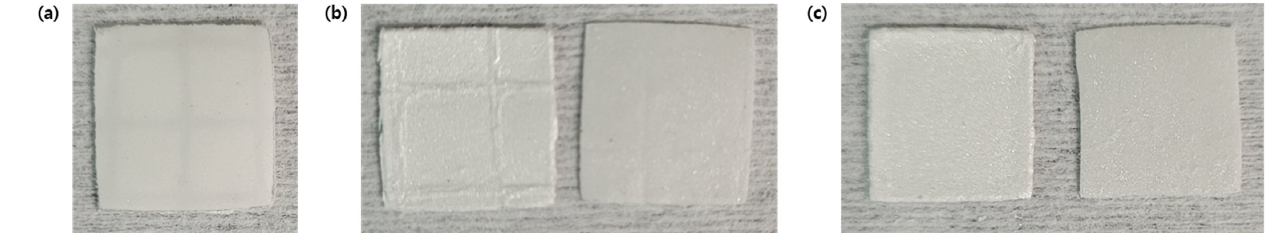
Figure 7. Digital photos of ( a ) Al/h-BN/Al-1, ( b ) Al/h-BN/Al-2, and ( c ) Al/h-BN/Al-3 composites after punching. Complete delamination was observed for the punched Al/h-BN/Al-2 and Al/h- BN/Al-3 composites.